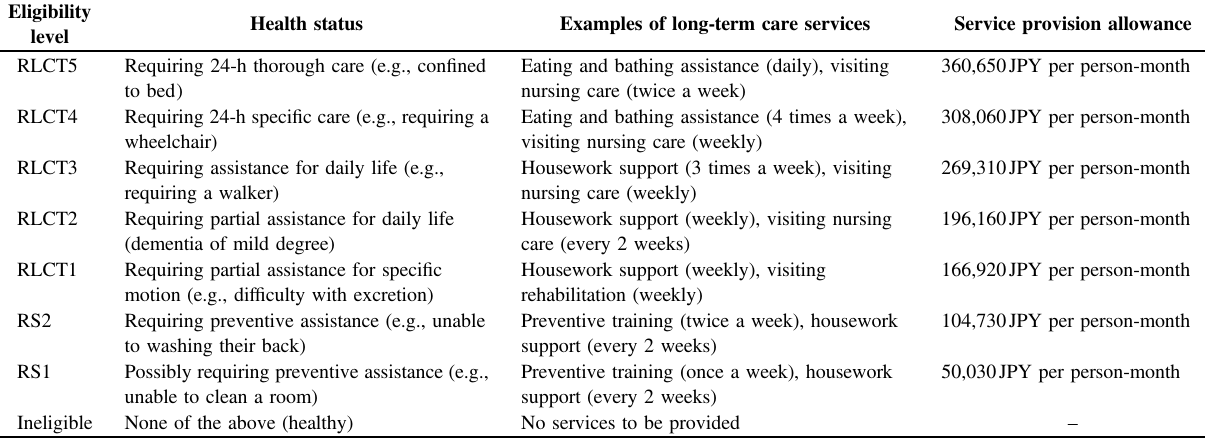
Table 1 Eligibility levels for long-term care insurance in